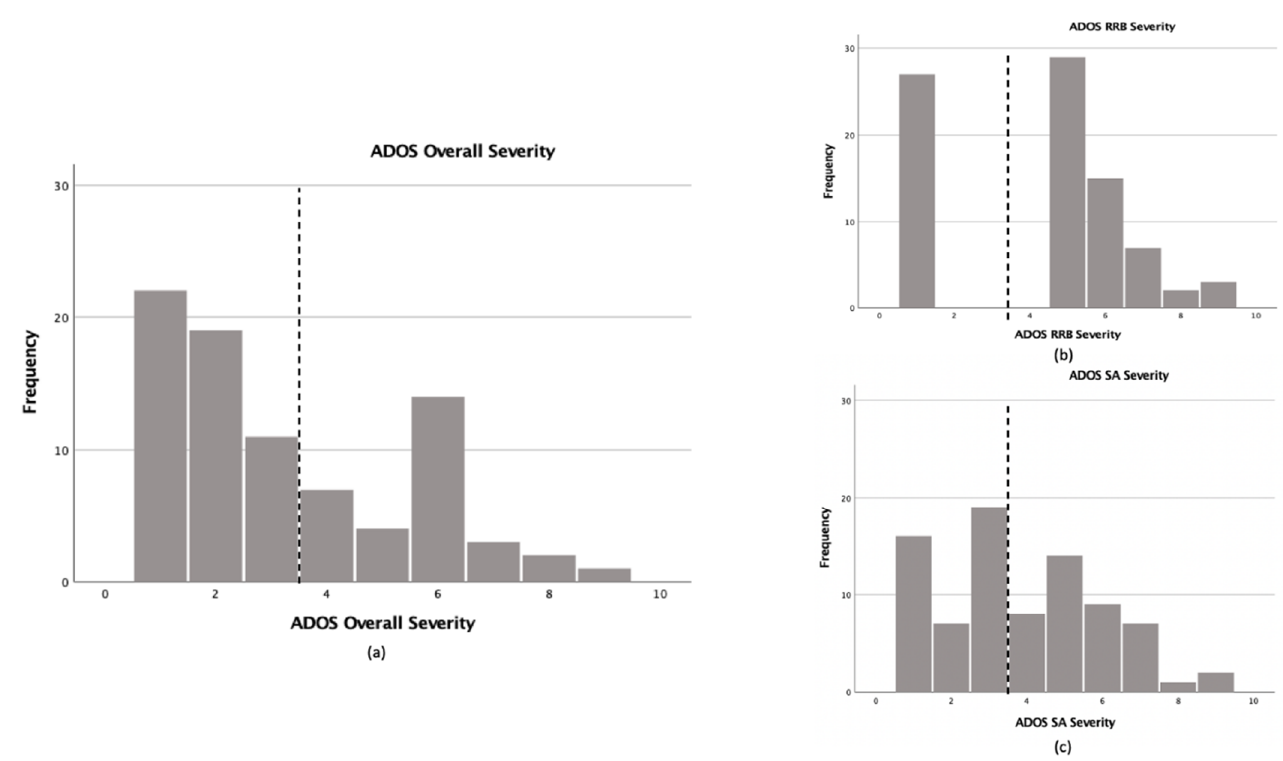
Figure 1. Frequency distribution of ADOS-2 CSSs across sample; ( a ) ADOS-2 Overall CSS for overall sample; ( b ) ADOS-2 RRB-CSS for overall sample; ( c ) ADOS-2 SA-CSS for overall sample. Note: Dotted line represents CSS cutoff for ASD classification.